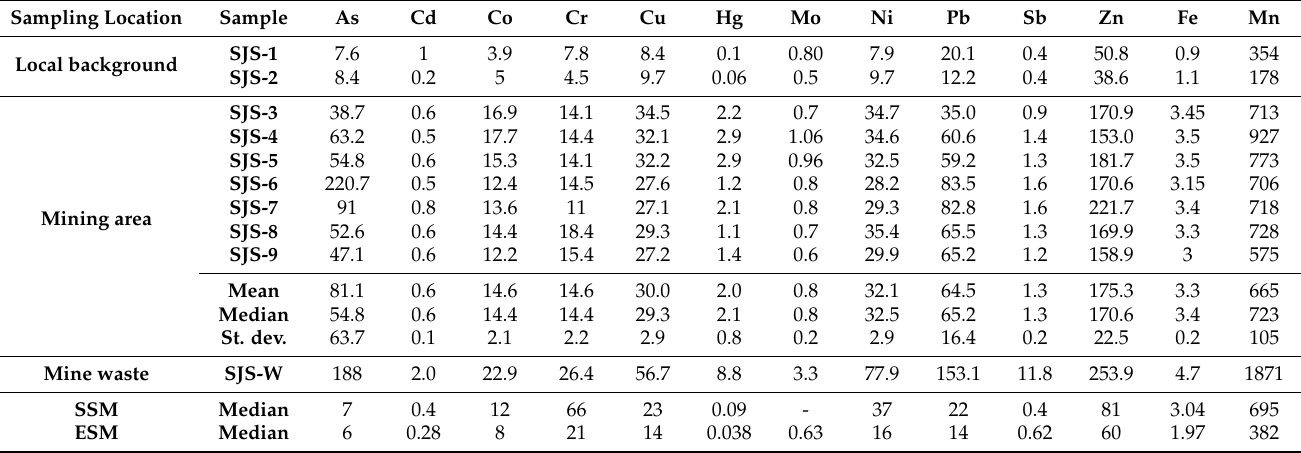
Table 2. Contents of PTEs (mg/kg), Fe (g/kg), and Mn (mg/kg) in the studied stream sediments and mine waste material. Mean, median, and standard deviation values are calculated only from samples from the mining area. Slovenian (SSM) [54] and European (ESM) [55] median values for stream sediments are shown for